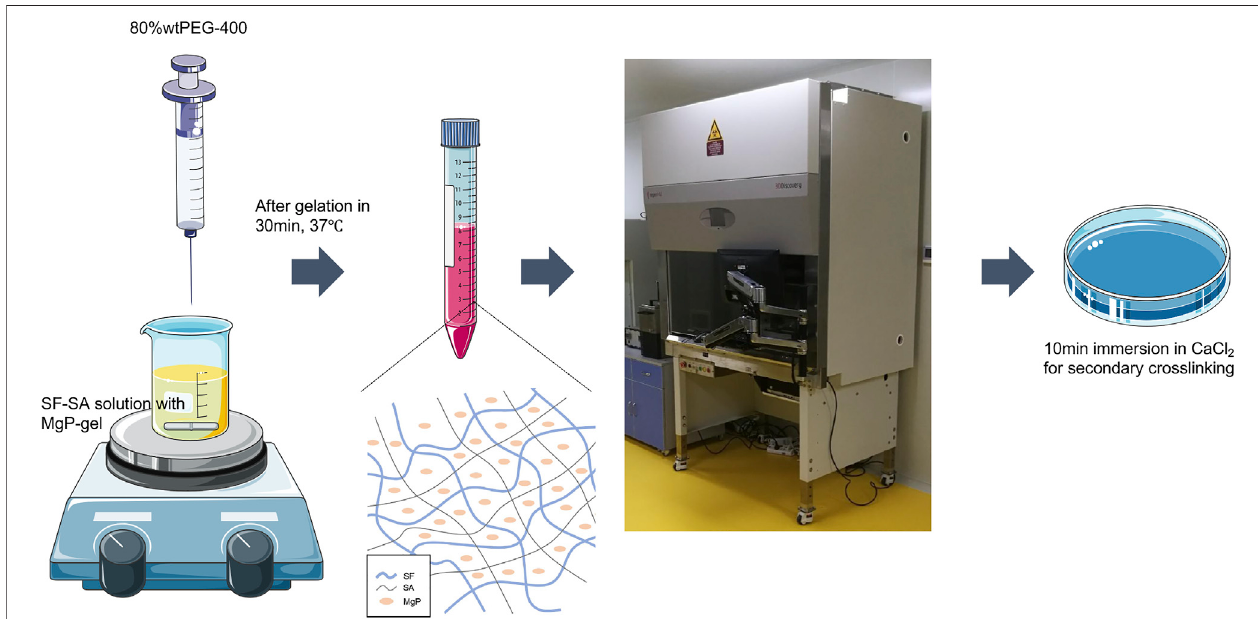
FIGURE 1 | The fl ow chart is an illustration of how the SF-SA and SF-SA/MgP hydrogel scaffolds were fabricated. The whole process was in a sterilized environment.